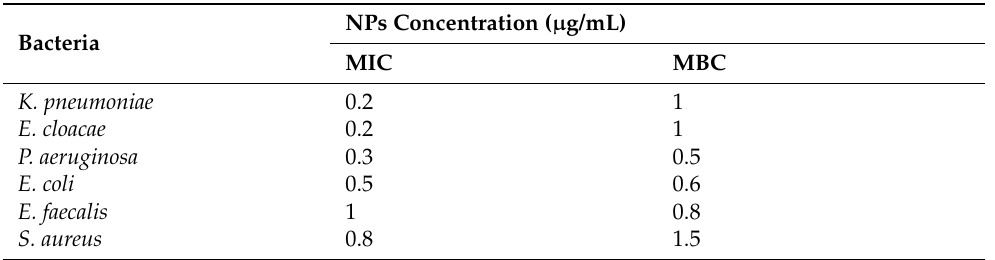
Table 2. Minimum inhibitory concentration (MIC) and minimum bactericidal concentration (MBC) of Ag-Cu NPs against different bacterial